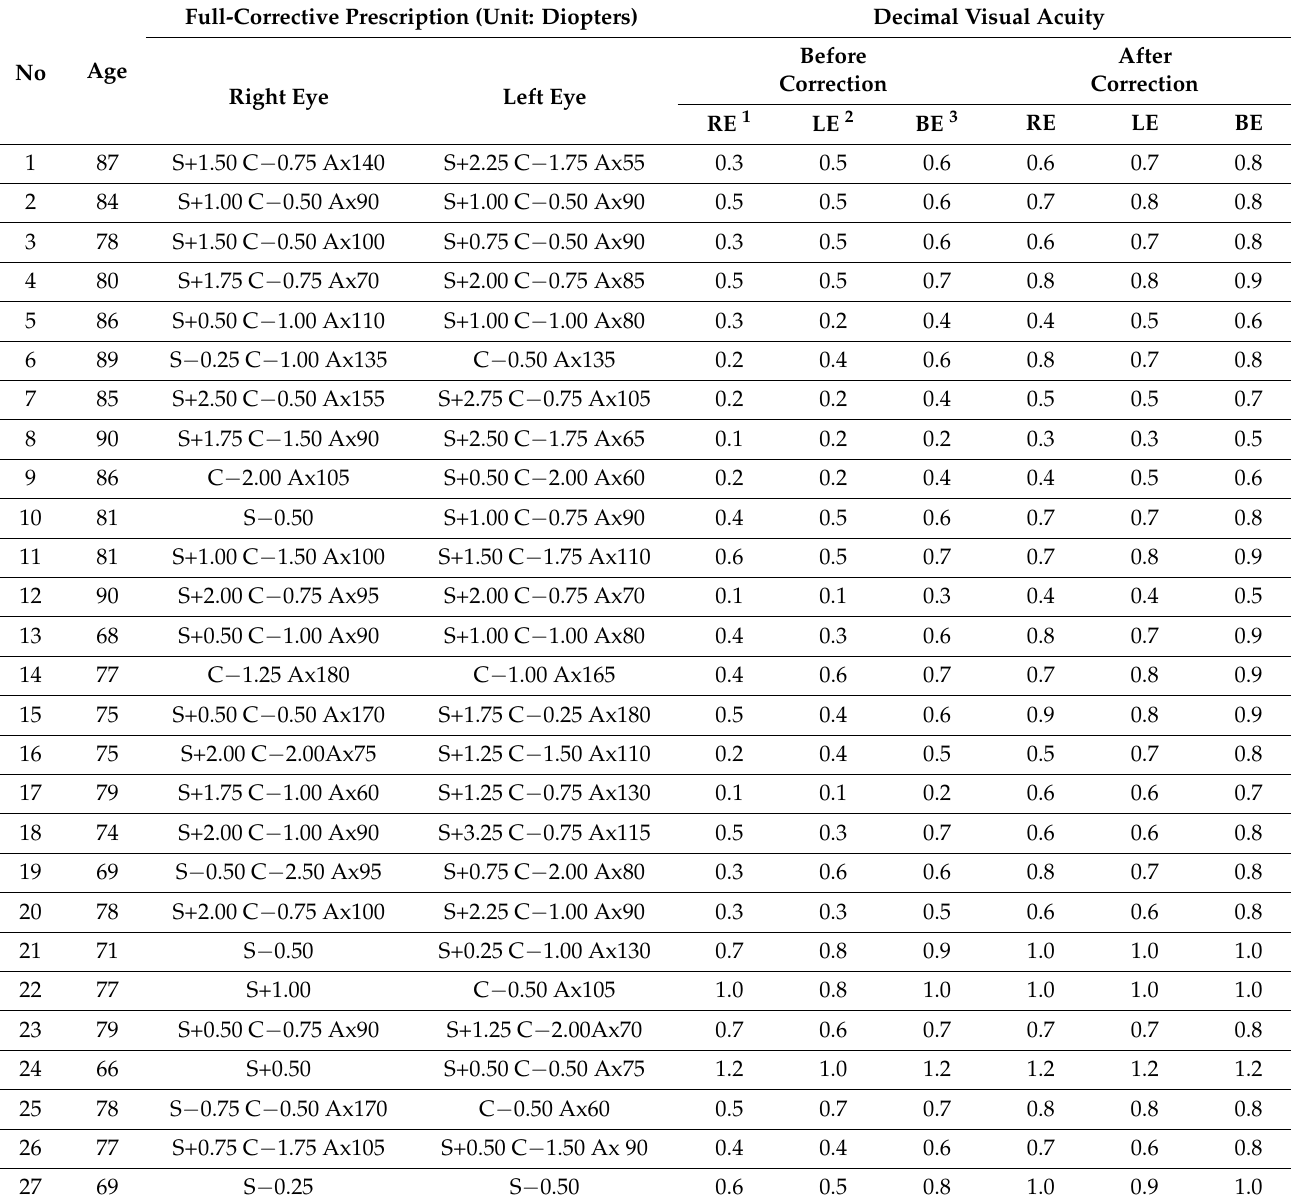
Table 1. Information of full corrective prescription and visual acuity in all